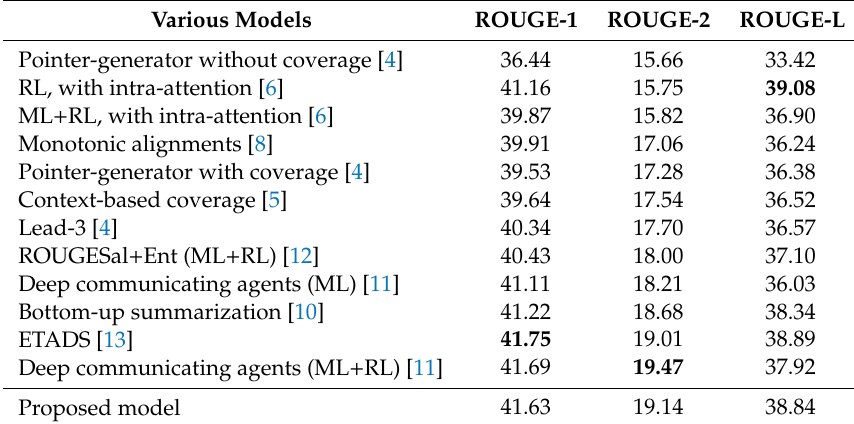
Recall-oriented understudy for gisting evaluation (ROUGE) F1 scores of automatic summarization